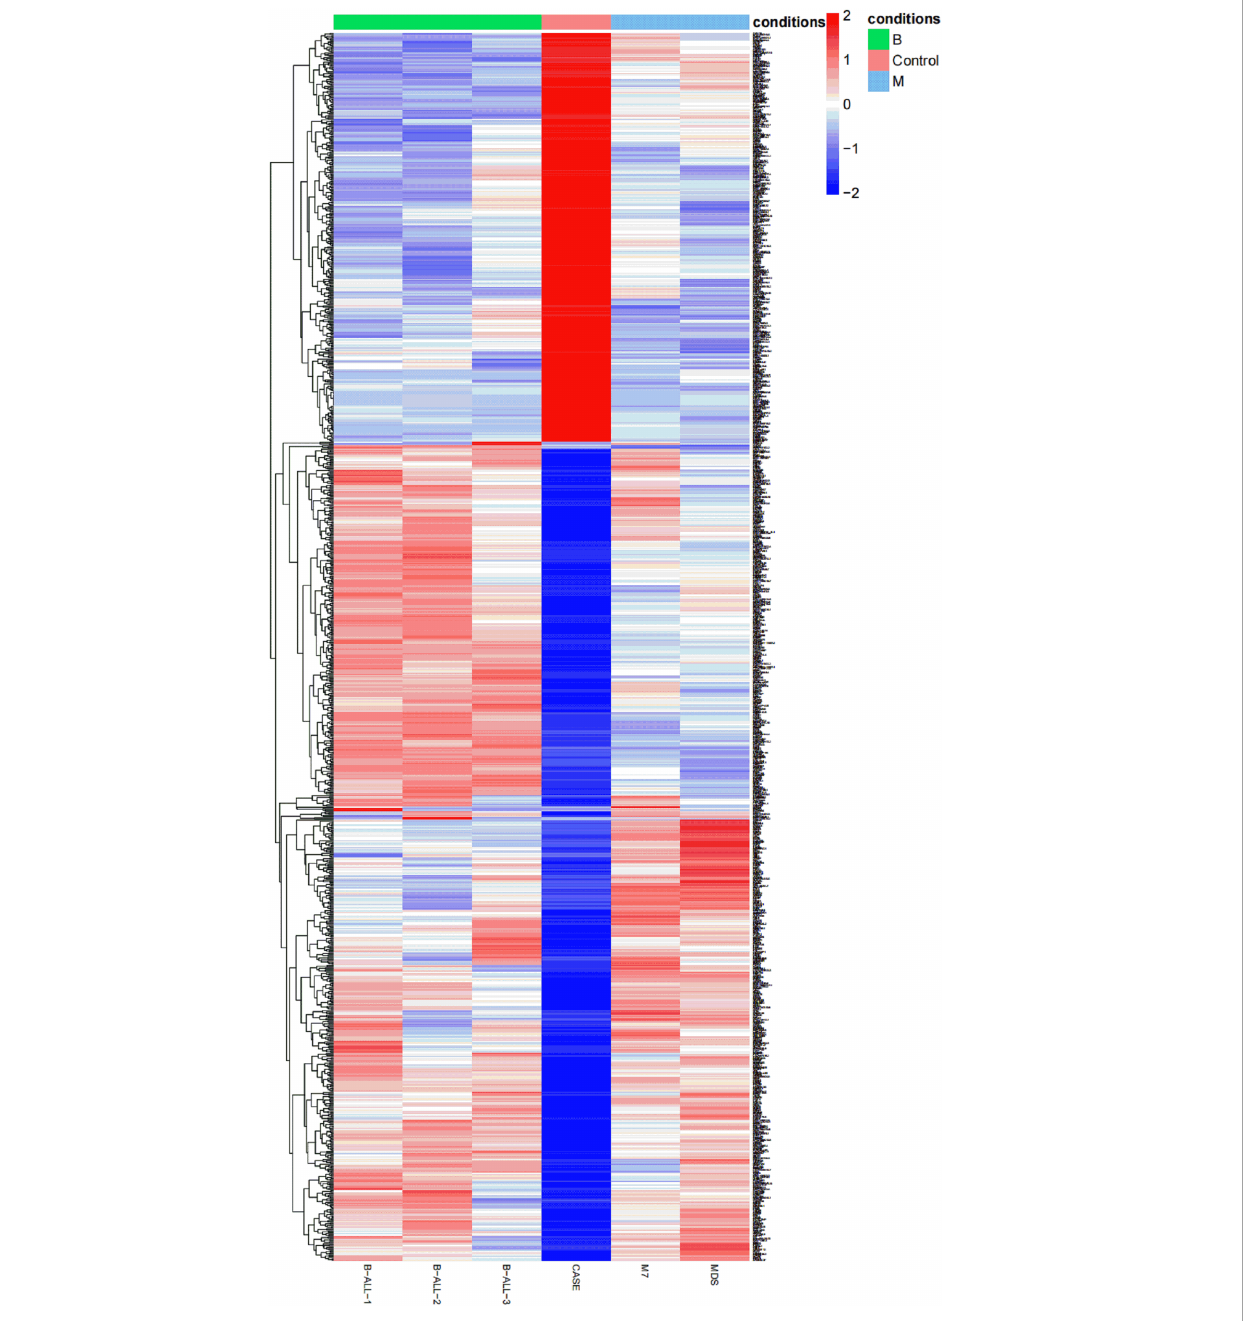
FIGURE 3 A heat map is created based on the total RNA expression of six patients with hematologic malignancies: the relative expression abundance of each gene in B-ALL, APL with FIP1L1::RARA , M7, MDS. The coloured scale varies from deep blue to deep red, which indicates low or high